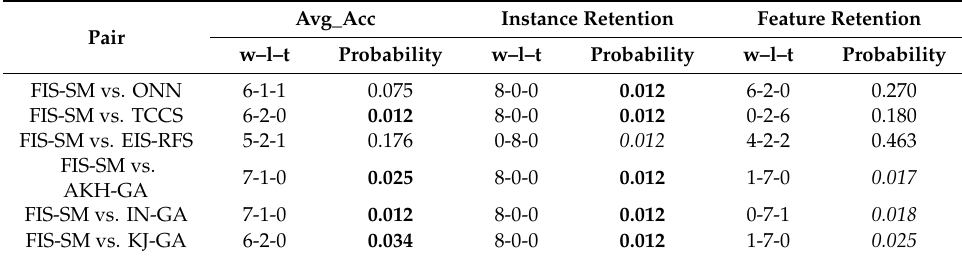
Table 14. Results of the Wilcoxon test comparing the performance of the algorithms over repository